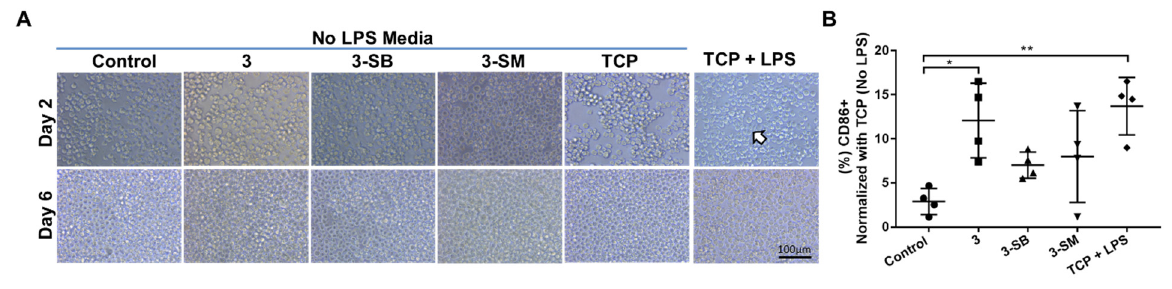
Figure 5. Human monocytic THP-1 cell polarization to M1 macrophage phenotypes in presence or absence of hydrogels and LPS. ( A ) THP-1 cells were cultured on different hydrogels and on TCP for 6 days. Morphological changes of cultured cells in presence of LPS are marked with arrow. ( B ) At day 6, the expression of CD86 (pro-inflammatory M1 marker) was evaluated and compared between the hydrogel groups, and percentage expression data was normalized to TCP (No LPS). Quantitative results were reported as the mean ± S.D. from four independent samples. * and ** represent p < 0.05, and p < 0.01, respectively.